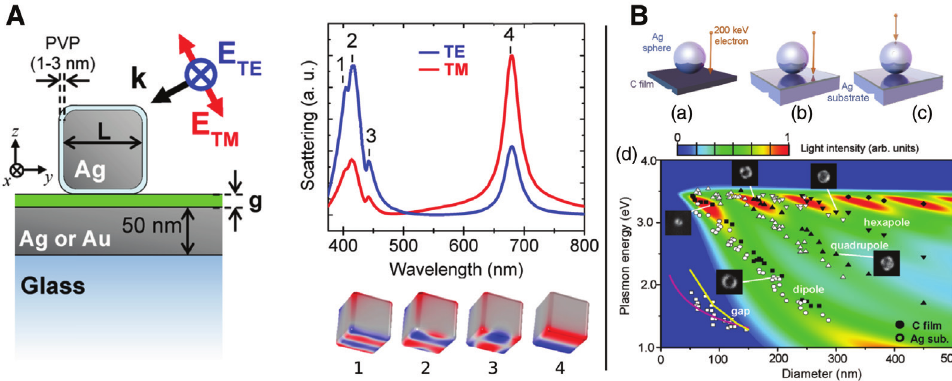
Figure 14: (A) Left: system investigated in [35], constituted by a 80-nm silver nanocube separated from a silver/gold film by a thin dielectric layer of alternating layers of PAH and polystyrene sulfonate. The silver cube is covered by a 3 nm-thick layer of aluminum oxide and excited by a plane wave in oblique incidence; Right: computed scattering spectra for the two incident polarizations (top) and distri- bution of the surface charges for each of the four modes indicated (bottom); (B) Top: investigated system in [36], constituted by a silver nanosphere placed on top of a carbon or silver substrate, with the position of the incident electron beam; Bottom: the colormap shows the calculated cathodoluminescence intensity from self-standing particles under grazing incidence, together with the experimental position of the Mie- and gap-plasmon modes obtained by EELS on carbon and silver substrate. The yellow and magenta curves are the size-dependent gap-plasmon position obtained from analytical and numerical simulations, respectively. Reprinted with permission from Nano Lett., 2013, 13 (12), pp 5866–5872. Copyright 2013 American Chemical